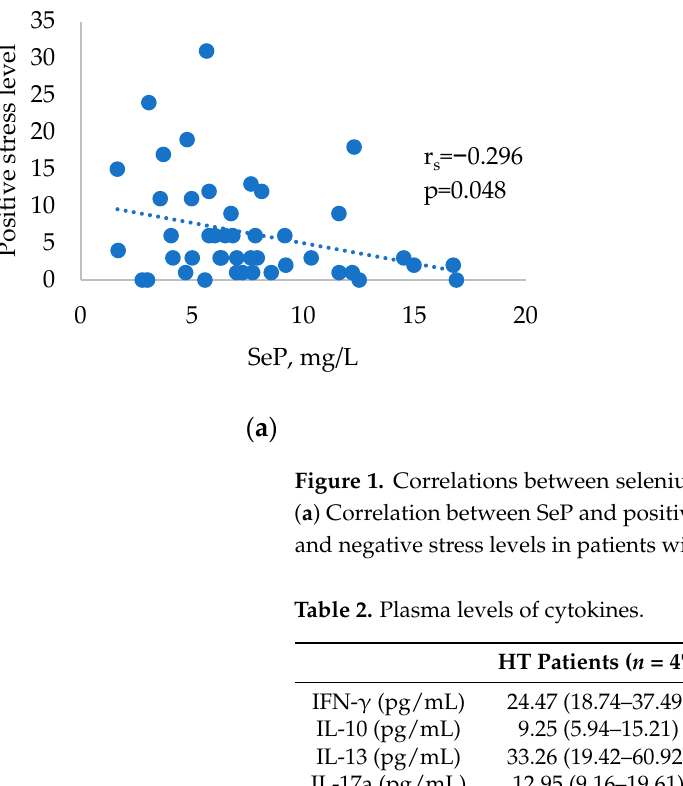
Table 2. Plasma levels of cytokines.